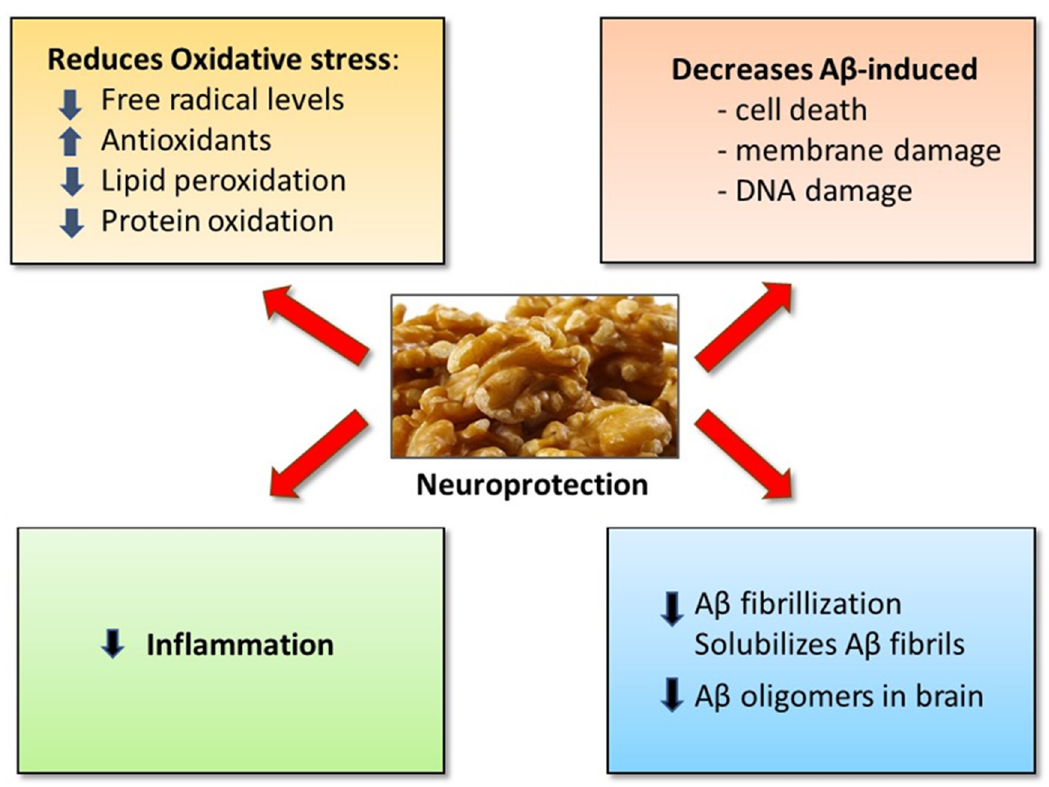
Figure 1. Potential mechanisms for neuroprotective effects of walnuts in reducing the risk of mild cognitive impairment (MCI) and dementia.